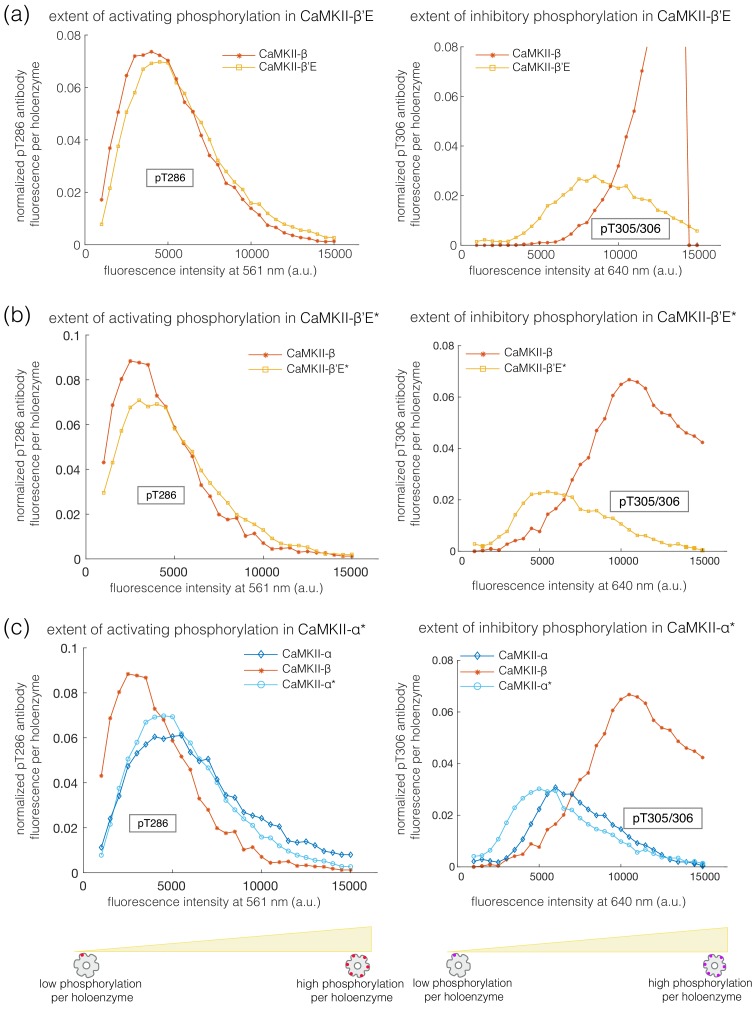
Autophosphorylation status of activated CaMKII-β/β* variants.(a) Comparison of the extent of phosphorylation at the activating site (left panel) and the inhibitory site (right panel) for CaMKII-β and CaMKII-β’E holoenzymes with detectable phosphorylation. (b) Comparison of the extent of phosphorylation at the activating site (left panel) and the inhibitory site (right panel) for CaMKII-β and CaMKII-β’E* holoenzymes with detectable phosphorylation. (c) Comparison of the extent of phosphorylation at the activating site (left panel) and the inhibitory site (right panel) for CaMKII-α, CaMKII-β and CaMKII-α* holoenzymes with detectable phosphorylation (see Materials and methods for details of normalization).